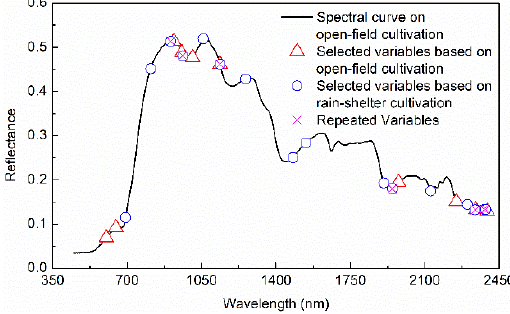
Figure 6. Fusion of characteristic